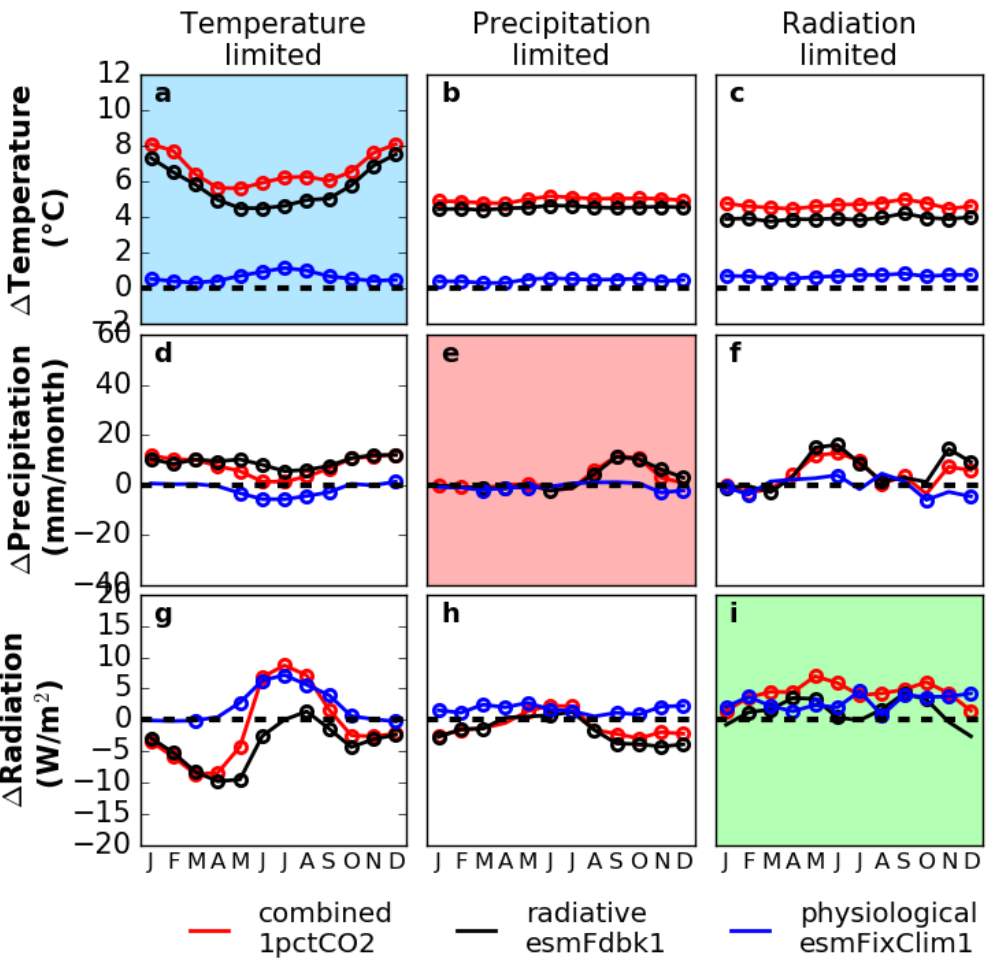
Figure 7. Additive and counteracting impacts of CO 2 on climate. Simulated changes in climate and vegetation from the CMIP5 eight-model ensemble in response to increasing CO 2 from 280 ppm by 1%/year for 140 years: temperature, a – c ; precipitation, d – f ; and radiation, g – i . The changes are the mean of the last ten years minus the mean of the first ten years (see Figures 8 and 10 for a spatial representation of the changes). In order to assess the contribution of radiative and vegetation physiological effects on climate and vegetation, three experiments were carried out: (1) CO 2 has a radiative forcing on climate but no direct effect on vegetation; (2) CO 2 has a vegetation physiological impact, primarily on internal CO 2 concentration and stomatal conductance, but does not directly alter radiative forcing; and (3) CO 2 has a combined effect on both radiative forcing and physiological impacts. Shading is used to highlight changes in the limiting factor for each of the three regions (e.g., blue shading highlights temperature changes in the temperature-limited region). Circles indicate that the trend in the 140-year ensemble mean is significant at the 95% level from a Mann–Kendall trend test.